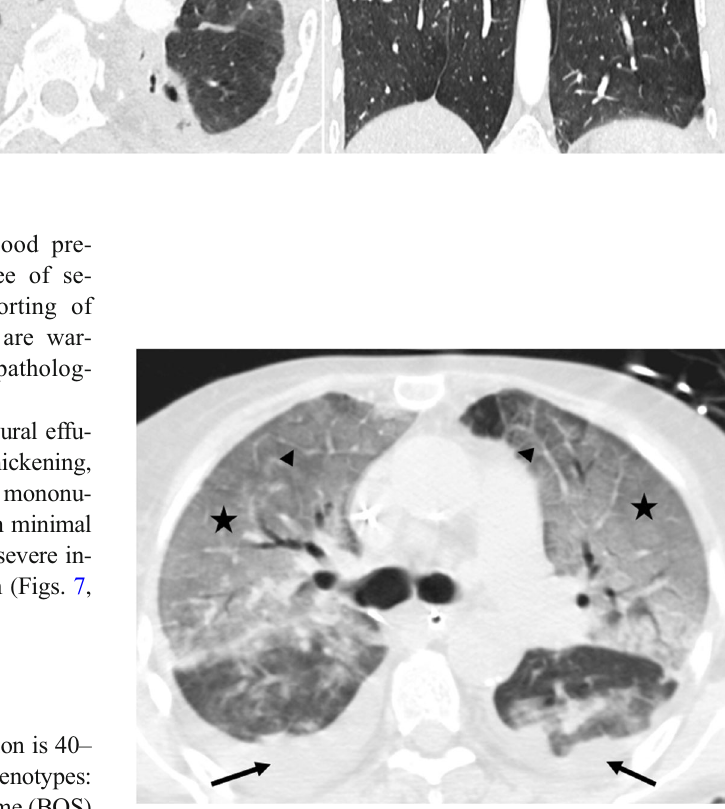
Fig. 12 Restrictive allograft syndrome (RAS). Dyspnea and irreversible decline in forced expiratory volume (FEV) and total lung capacity (TLC). Peripheral condensations and subpleural thickening ( arrows ), bronchiectasis ( arrowheads ) ( a ) and volume loss with upper lobe predominance ( stars ) ( b ). RAS was confirmed by biopsy